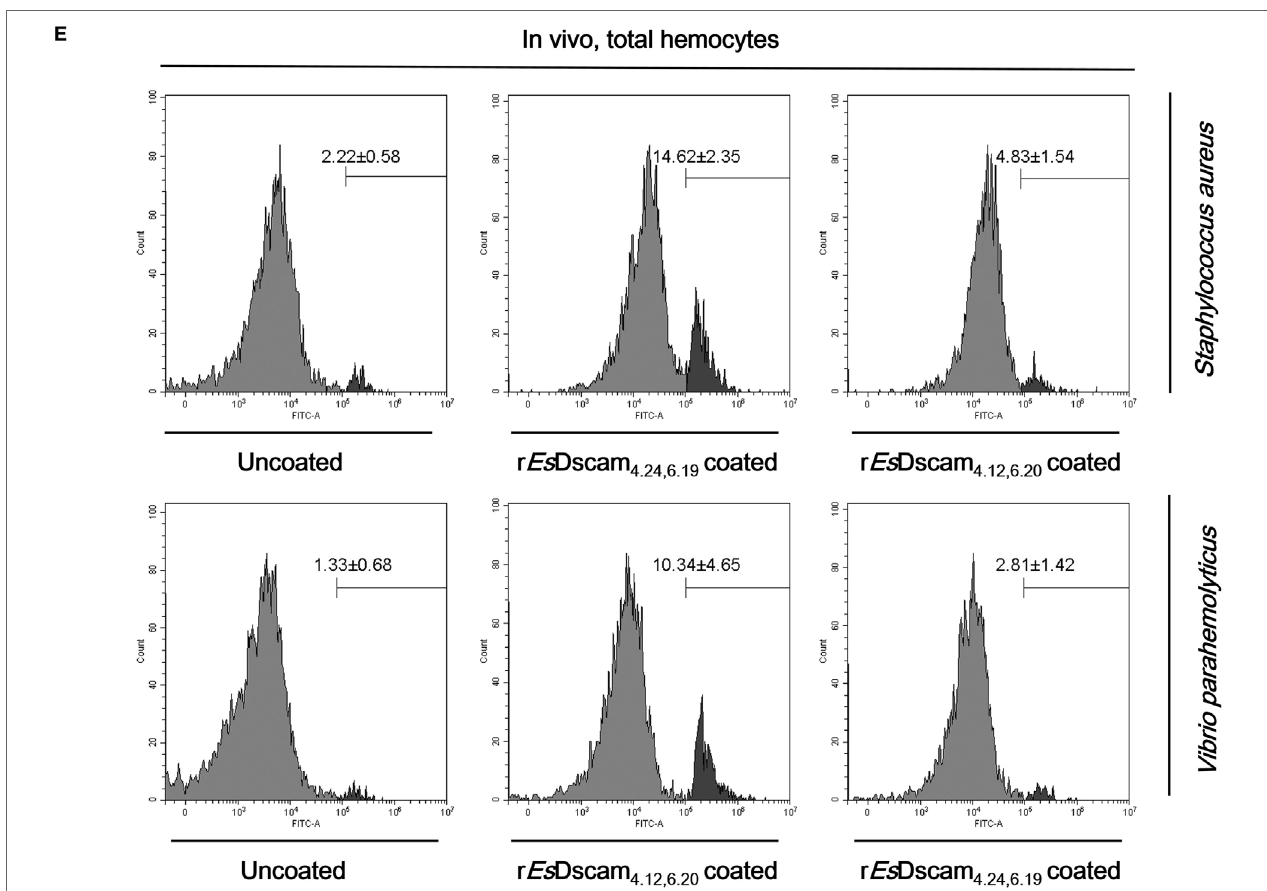
FigUre 5 | Soluble Es Dscam enhanced the phagocytosis of bacteria in hemocytes. (a,B) r Es Dscam 4.24,6.19 promote phagocytosis of Staphylococcus aureus in vitro . S. aureus (1 × 10 6 microbes) labeled with FITC and then coated with r Es Dscam 4.24,6.19 or r Es Dscam 4.12,6.20 protein was used to stimulate cultured hemocyte, with uncoated bacteria as control. Hemocytes was then collected 1 h later, washed with PBS. After staining with DAPI and quenching with trypan blue, hemocytes were observed under a fluorescence microscope. Scale bar = 15 μ m. The phagocytosis ( left panel ) were detected by fluorescence microscopy, data representative three independent repeats. The phagocytosis rate ( right panel ) were calculated according to the formula presented in Section “Materials and Methods” based on counting 500 hemocytes in each experiment. Three independent repeats were performed, and results are expressed as the mean ± SD. Data were analyzed by one-way ANOVA and the letters (a, b) presented significant differences ( p < 0.05). (c,D) r Es Dscam 4.12,6.20 promote phagocytosis of Vibrio parahemolyticus in vitro . The same bacteria concentration, as well as the protocol and statistical method were used as described earlier. (e) Es Dscam promote phagocytosis of bacteria in vivo . S. aureus and V. parahemolyticus were heat-inactivated and labeled with FITC before coating with r Es Dscam 4.24,6.19 and r Es Dscam 4.12,6.20 , respectively. The bacteria were then injected into the hemolymph of crab and hemocytes were collected 1 h later for flow cytometric analysis. A total 10,000 hemocytes were counted for each sample. Three independent repeats were performed, and results are expressed as the mean ±